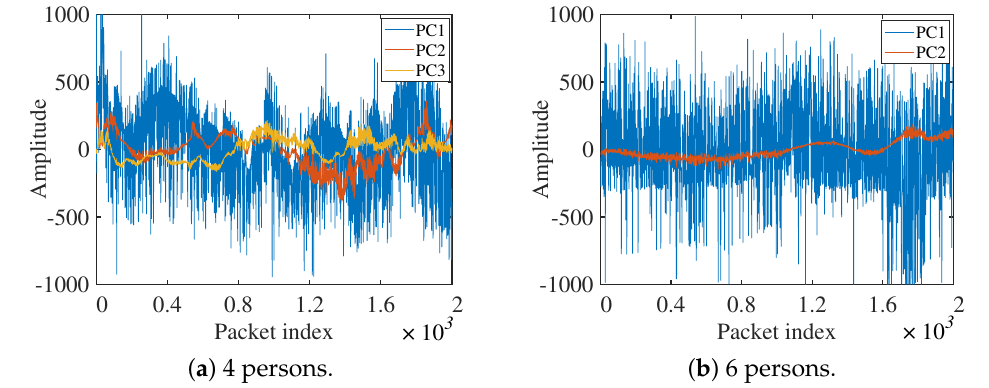
Figure 4. Sub-carrier decorrelation and PC